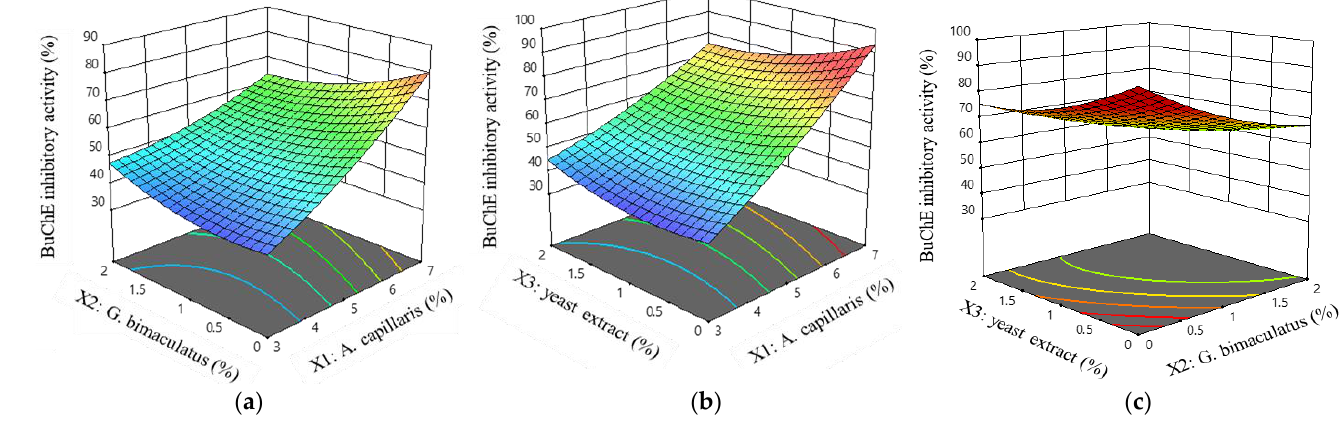
Figure 4. Response surface and contour plots for the BuChE inhibitory activity of MKJW-fermented A. capillaris . A. capillaris and G. bimaculatus ( a ); A. capillaris and yeast extract ( b ); G. bimaculatus and yeast extract ( c ).